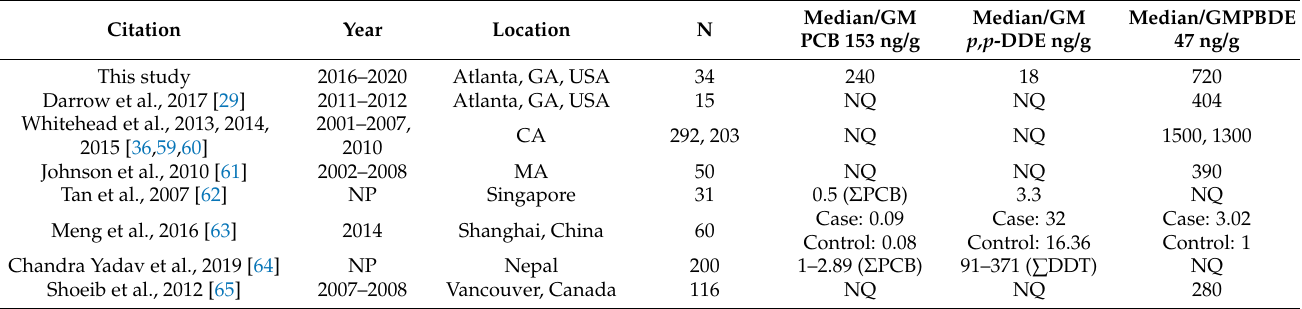
Table 4. Dust POP concentrations in various